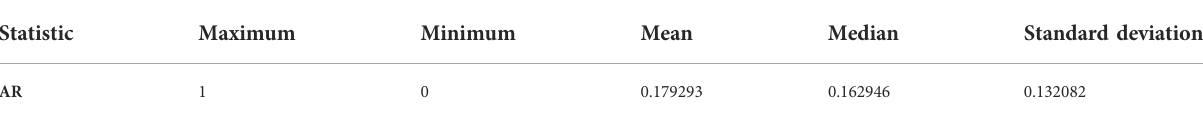
TABLE 3 AR descriptive